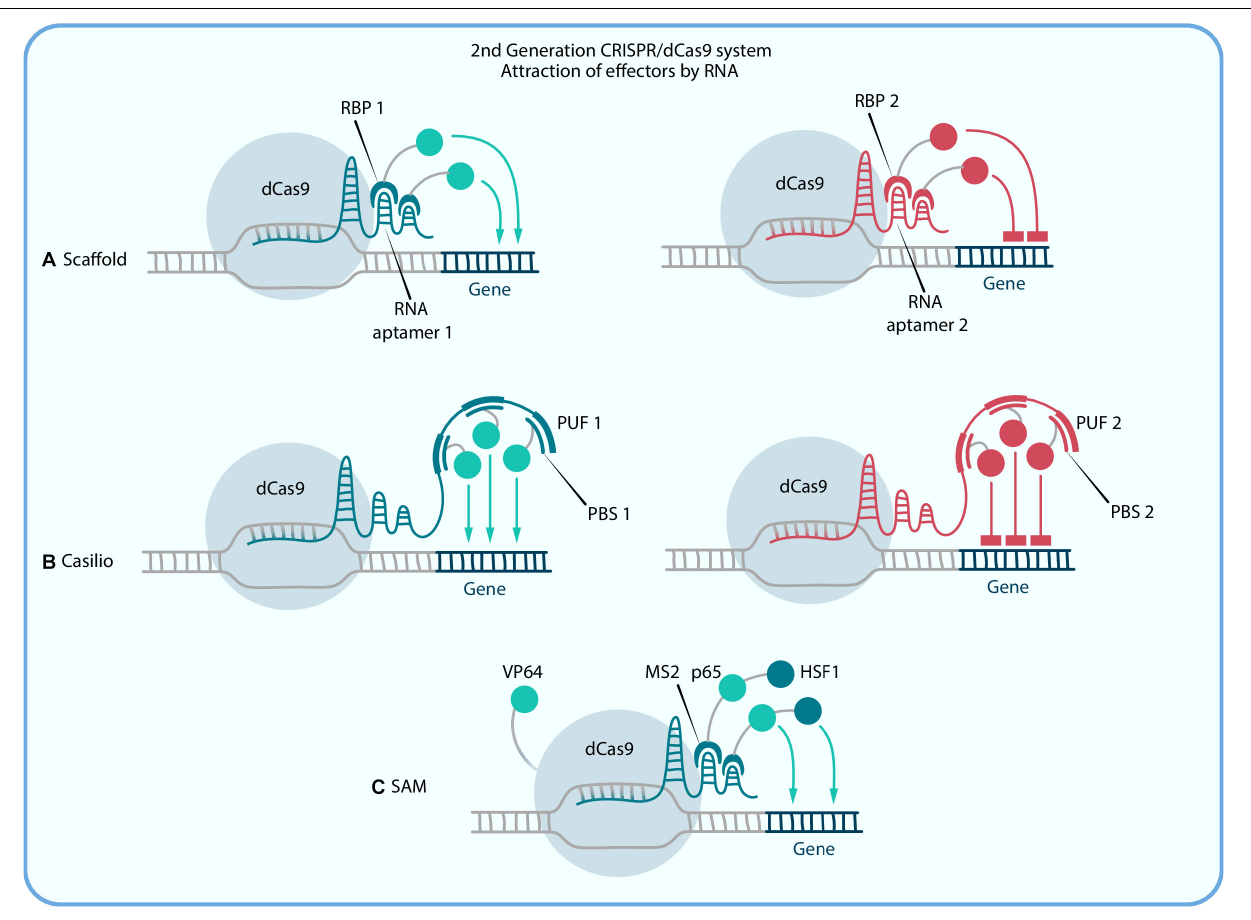
FIGURE 2 | Second generation CRISPR/dCas9 systems, which activation or repression is amplified due to recruiting multiple copies of an effector by RNA. (A) Scaffold and (B) Casilio systems use RNA regions [aptamers in Scaffold and PUF-binding site (PBS) in Casilio] for simultaneous recruitment of different effectors to different sgRNAs by RNA binding proteins (RPB in Scaffold and PUF in Casilio). (C) in SAM RNA binding protein MS2 is fused with two activator domains, p65 and HSF1, and dCas9 is also fused with activator